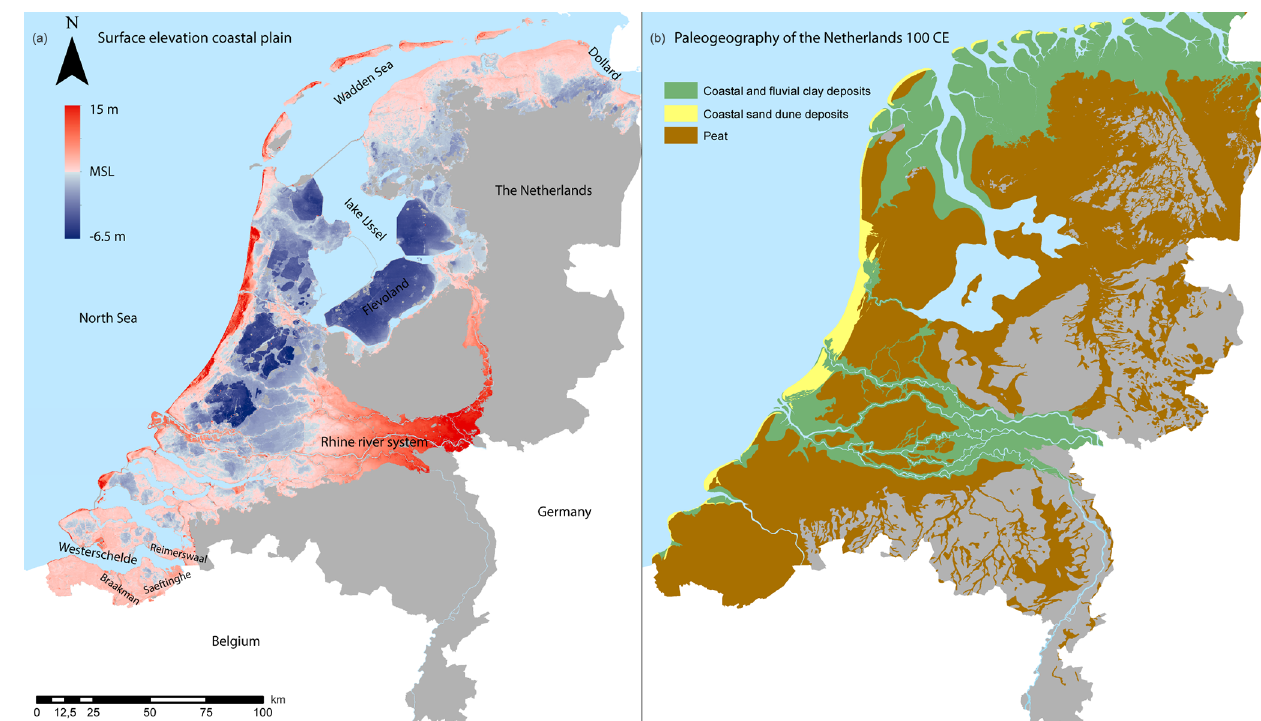
Figure 1. Maps showing: (a) The surface elevation of the coastal plain of the Netherlands and Rhine river system (©TNO Geological Survey of the Netherlands). Half the surface area of the coastal plain is situated below MSL. Provided geographical names are mentioned in this contribution. (b) Paleogeography of the Netherlands around 100 CE (Vos, 2015). Substantial parts of the coastal area are covered with peat that now largely disappeared by human activities. Sedimentation around 100 CE merely took place around river channels and in the north (Wadden Sea). Grey areas represent deposits of pre-Holocene